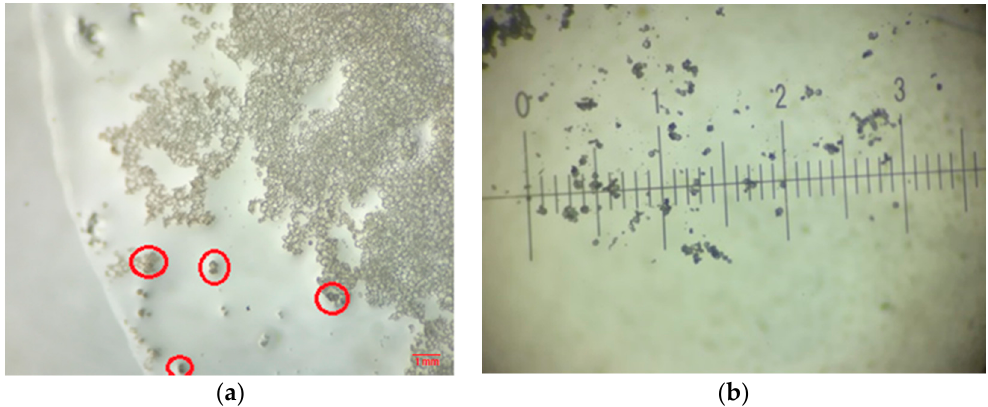
Figure 10. Optical image illustrating a ( a ) sample taken 30 min after the addition of ENB and a ( b ) sample after 12 h drying at room temperature (one division represents 100 µm).